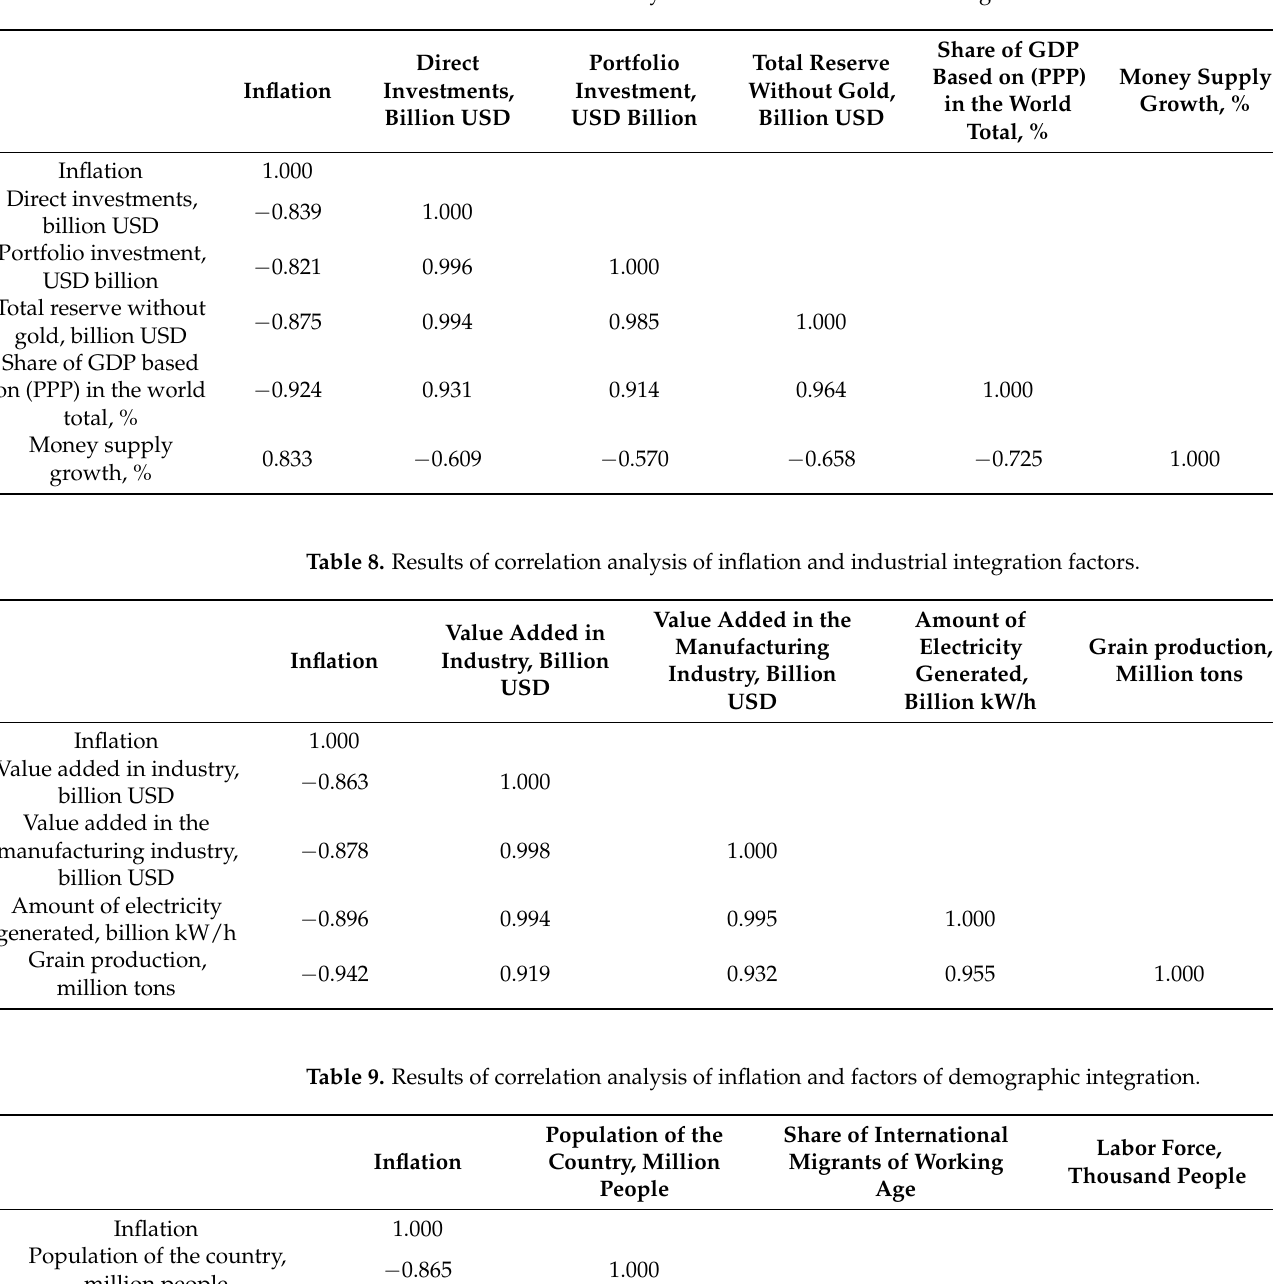
Table 7. Results of correlation analysis of inflation and financial integration factors.